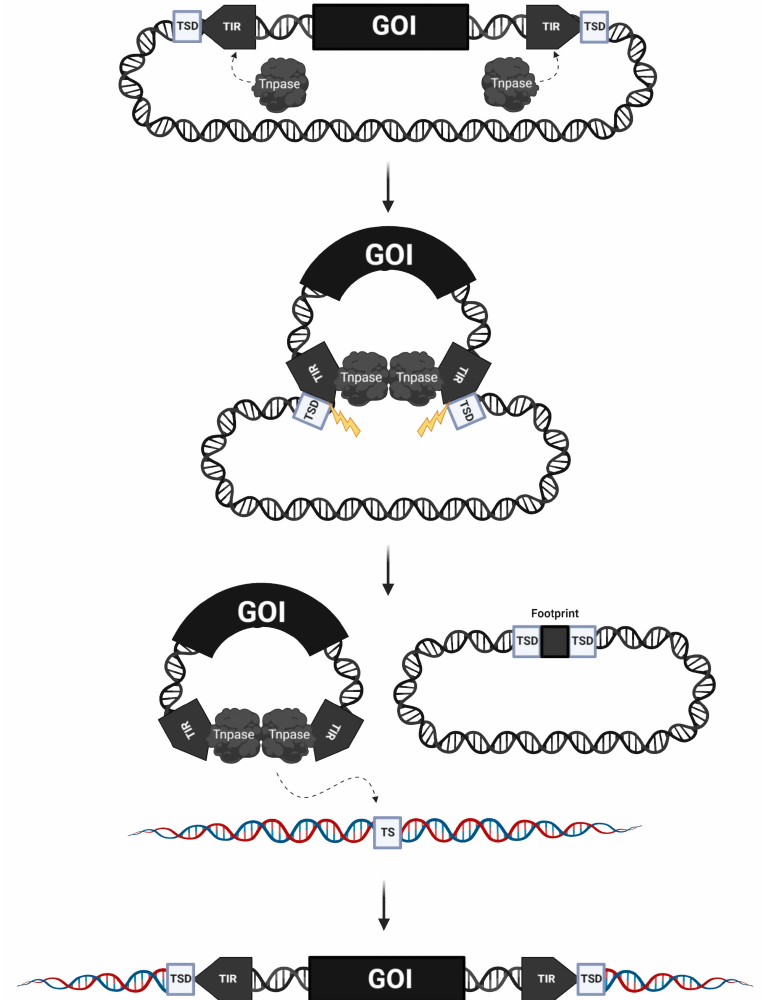
Figure 1. Schematic overview of transposase-mediated cut-and-paste transposition. A gene of interest (GOI, black bar) is mobilized by transposase (Tnpase) molecules (grey amorphous shape) from vector donor DNA (grey DNA stands) to a genomic locus (blue-red DNA strands). The transposase binds to the terminal inverted repeats (TIRs, grey arrows), induces double-stranded breaks (indicated with yellow lightning bolts), and excises the mobile element from the donor DNA leaving behind a footprint. The transposon-transposase complex finds a suitable target site (TS) and performs integration, producing a target site duplication